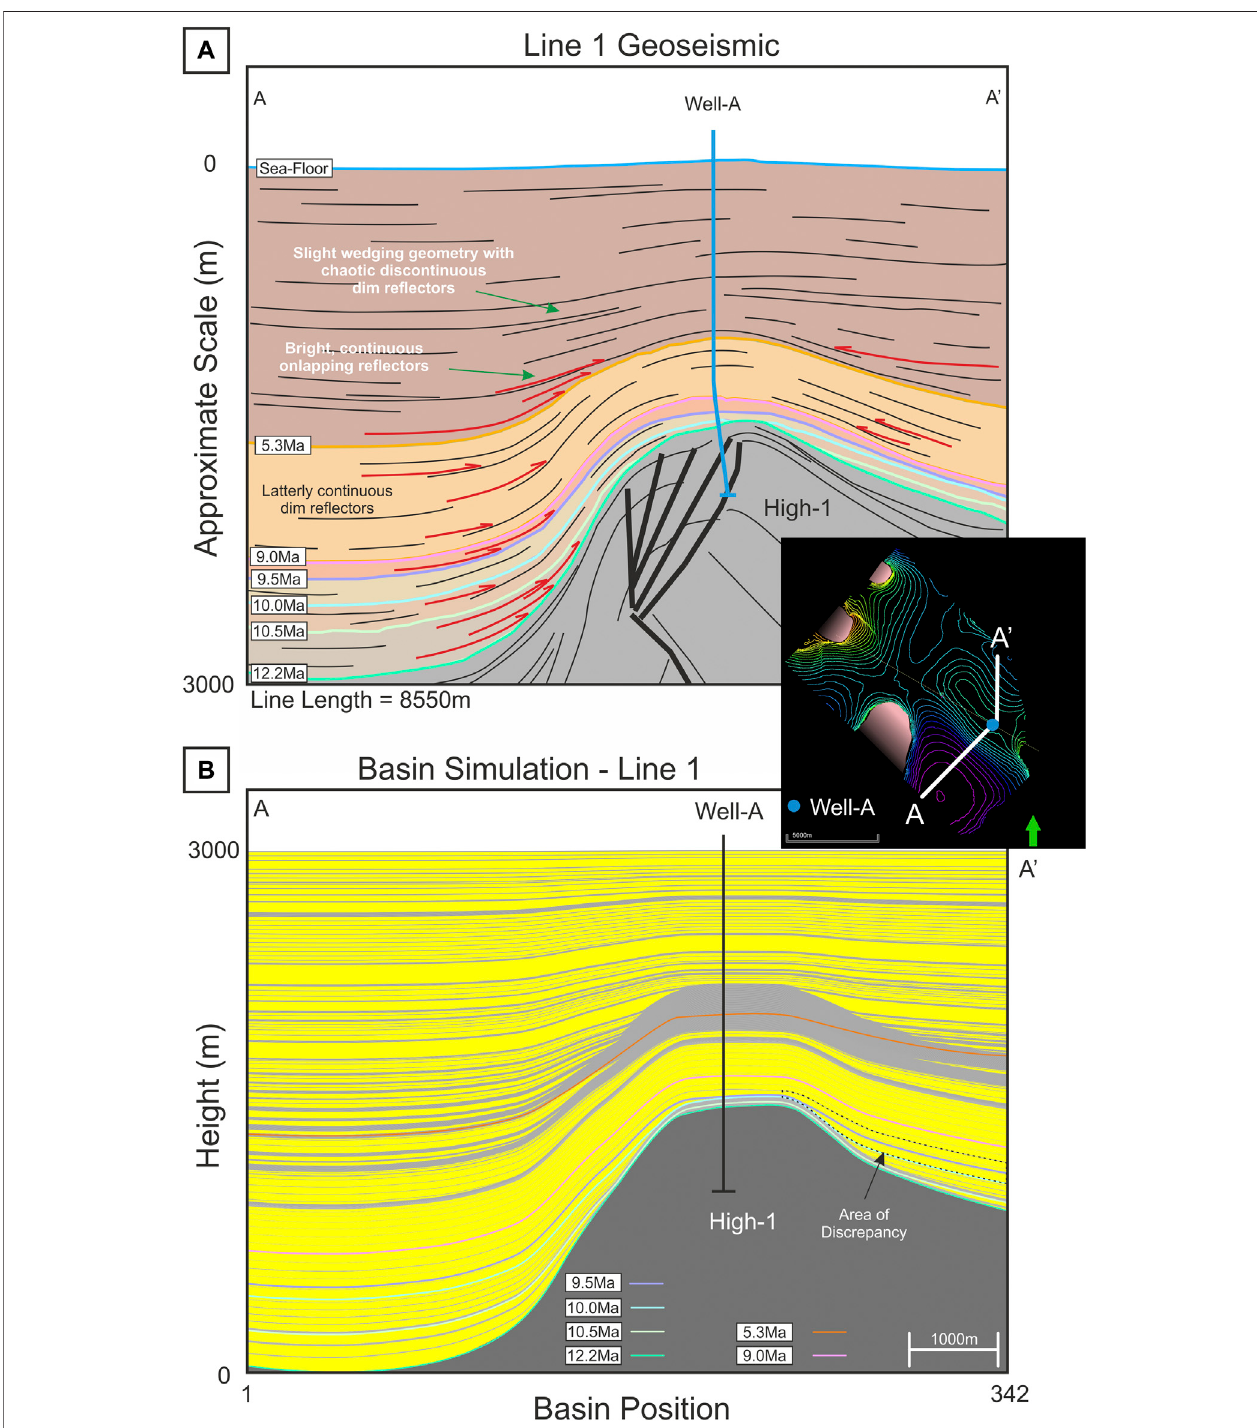
FIGURE5|(A) Geoseismiccross-sectionofLine1showingthepositionofWell-A,age-datehorizonstiedtoWell-A,andbriefannotationsoftheseismiccharacter. The red arrows show some of the major onlapping re fl ectors and thick black lines represent faults in High-1. Modelling was completed from 12.2 Ma until present day. With 12.2 – 5.3 Mabeingthefocusand matchedquantitativelytothesubsurfacedata,while 5.3 Mauntil present daywasmodelledtoalower,qualitativeresolutiononly. (B) Onlapse-2D fi nal simulation output of Line 1. We found there to be an overall good fi t between this and the subsurface data shown in (A) . The model produces good fi ts with the overall basin structure and form, as well as the thicknesses and stratal geometries found within the interpreted horizons. An area of discrepancy is shown on the northern fl ank of High-1.